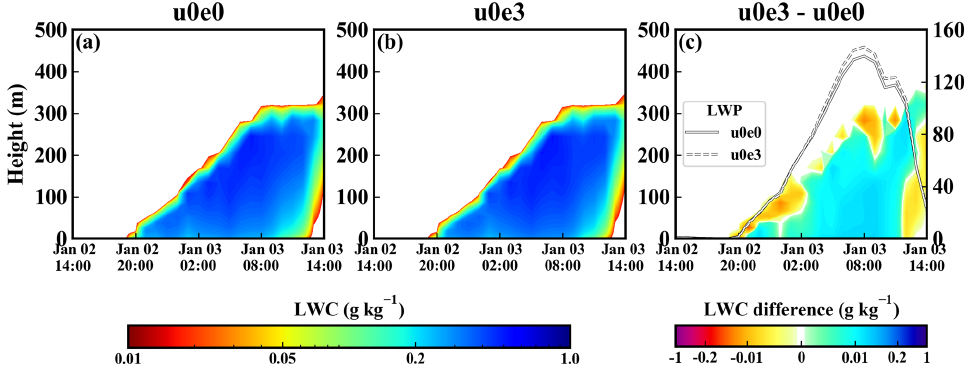
Figure 7. Similar to Fig. 5 but for the aerosol effect (u0e3 minus u0e0).